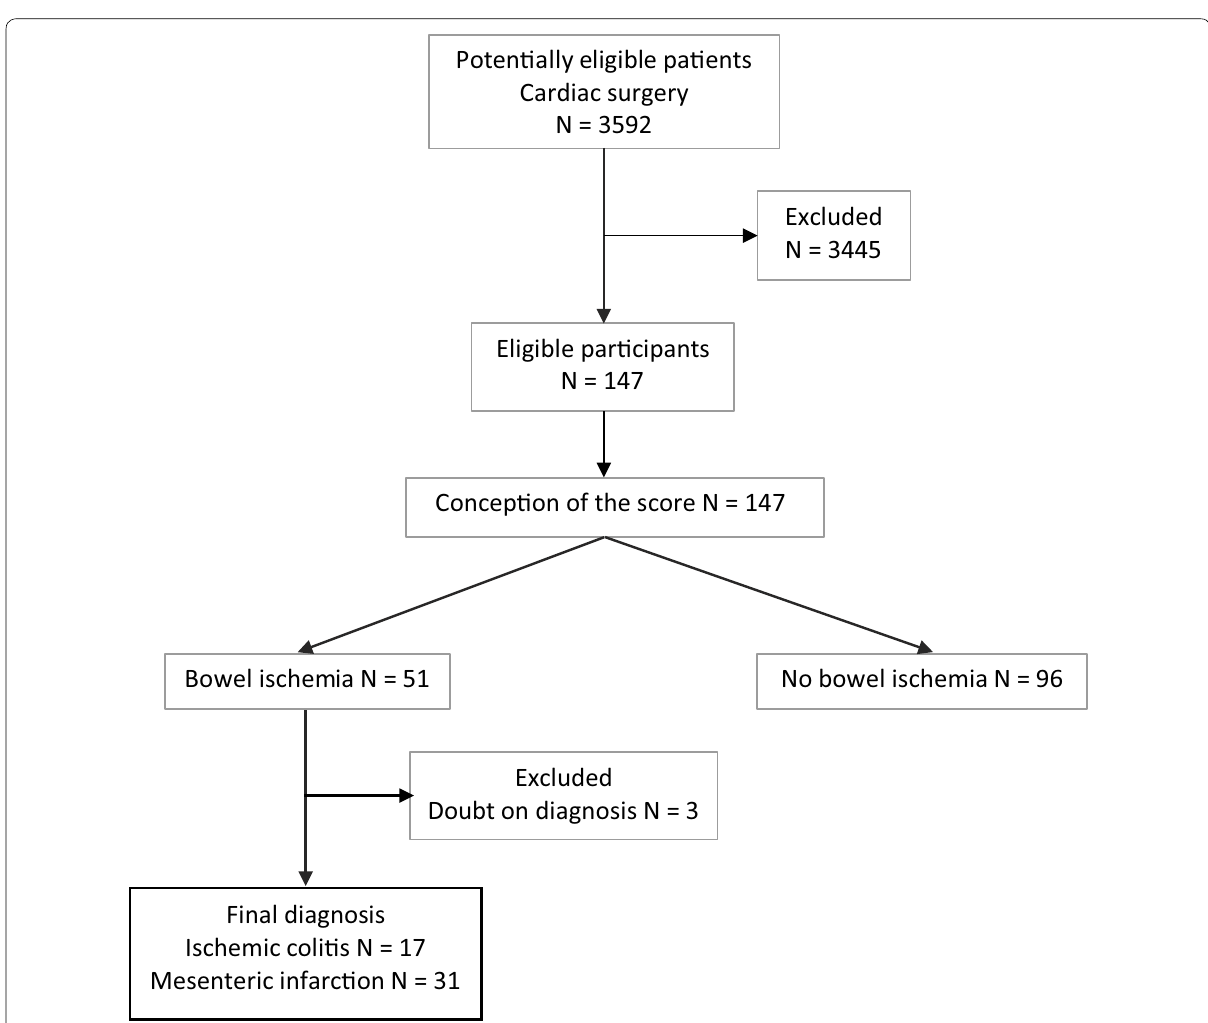
Fig. 1 Study flowchart (according to the STARD guidelines) describing the whole eligible population in the postoperative of cardiac surgery patients during the period of the study, leading to the final population studied in both